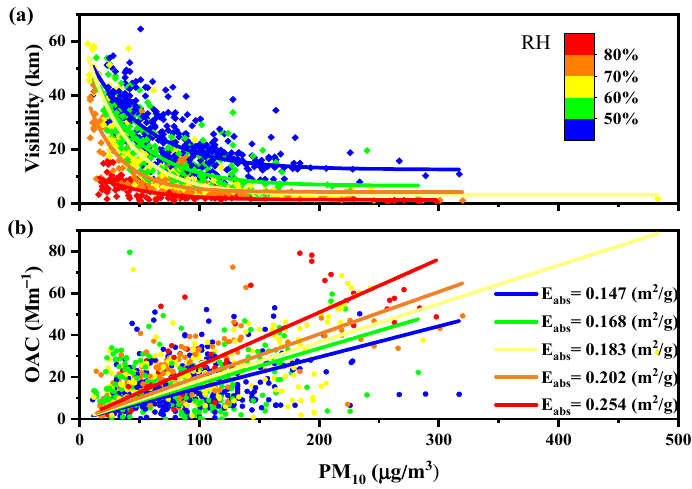
Figure 5. Visibility ( a ) and OAC ( b ) as a function of PM 10 mass concentration under different relative humidities ( RHs ). The blue, yellow, green, orange, and red lines present the fits of the dots for the different RH conditions.